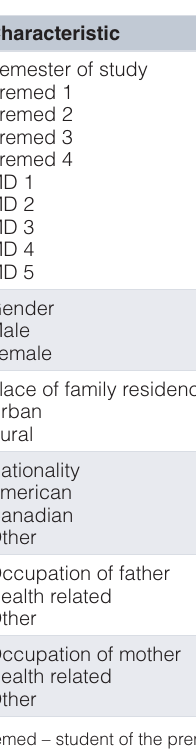
Table 1. Demographic characteristics of